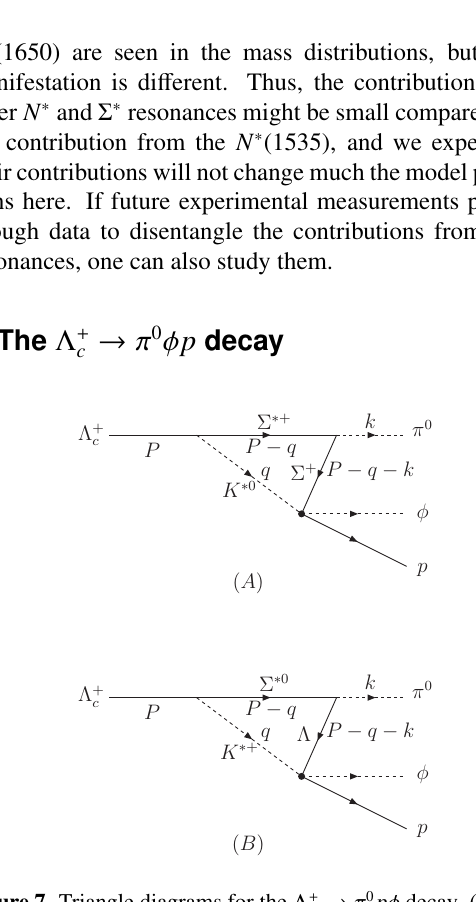
Figure 7. Triangle diagrams for the Λ + exchange. ( B ): Λ -exchange. The definitions of the kinematical variables ( P , q , k ) are also